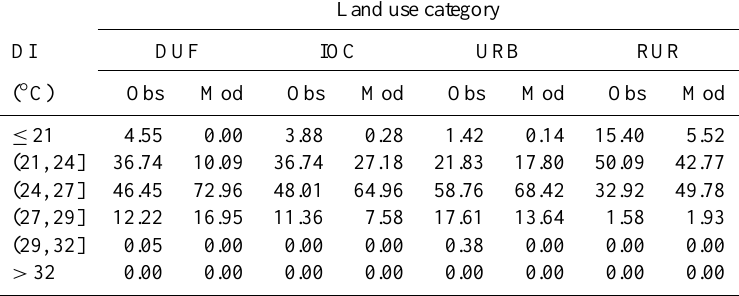
Fig. 8. Time series of observed (black solid line) and modeled (red solid line) (a) discomfort index, and (b) approximated wet-bulb globe temperature, averaged over all measurement sites. Statistical parameters are presented within the plots (MBE, RMSE, StDev: Standard Deviation). Table 4. Frequency distributions (%) of observed and modeled hourly DI values within the specified ranges, grouped by land use category. Land use category